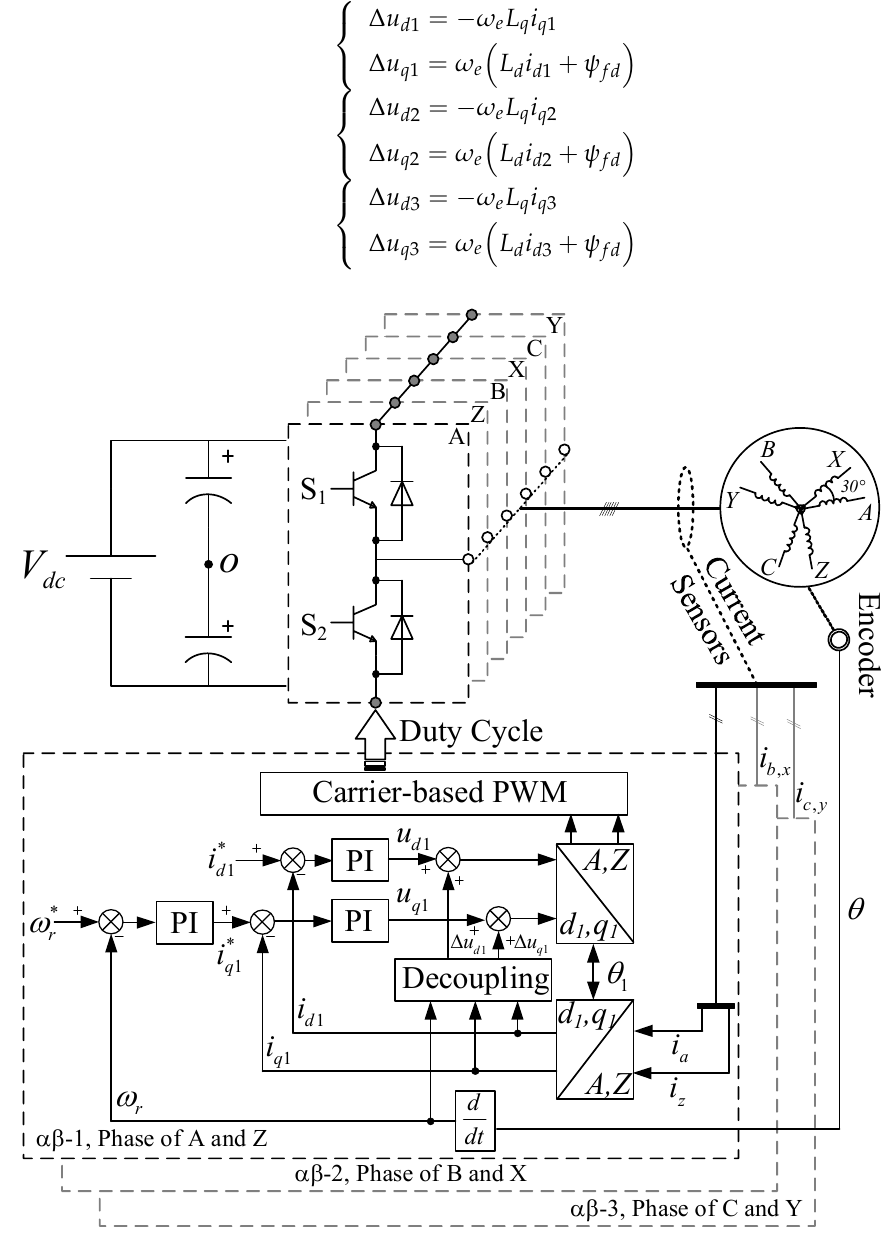
Figure 3. Control scheme of triple stationary frame.